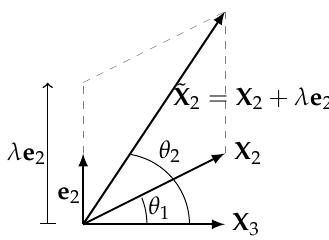
Figure 1. Representation of the raise